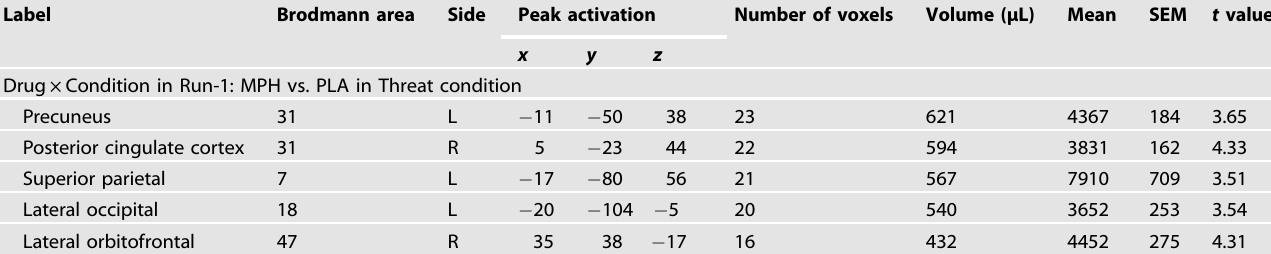
Table 1. Signi fi cant interaction clusters between Drug (MPH, PLA) and Condition (Safe, Threat) on WM load-related BOLD (3-Back vs. 1-Back) activation in